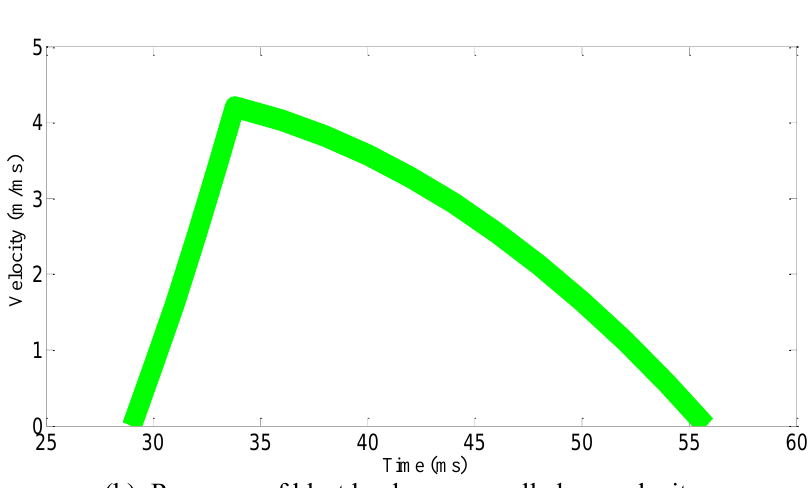
(a): Response of blast load on rear wall along displacement.